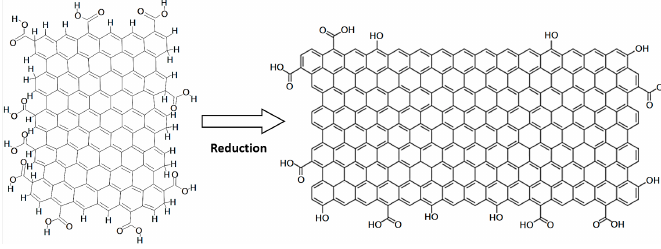
Figure 3. Reduced graphene oxide by microwave reduction.